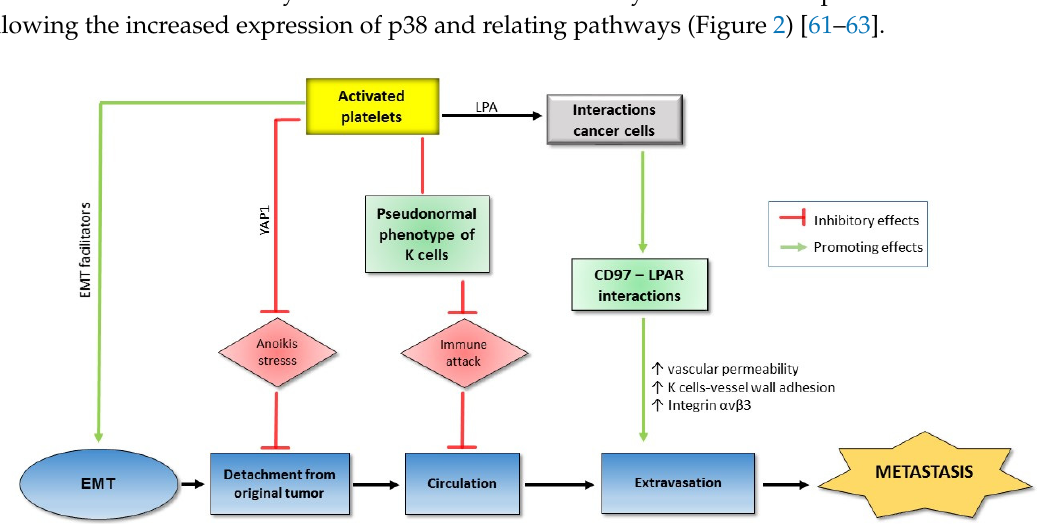
Figure 2. Platelets and tumor metastasis . Interactions between tumor cells and activated platelets, on the one hand, upregulate epithelial mesenchymal transition (EMT) facilitators and promote extravasation, and, on the other hand, protect the cancer cells from various dangers during the process of tumor detachment and circulation. As a result, tumor metastasis is promoted with supports of platelet ally (see text for